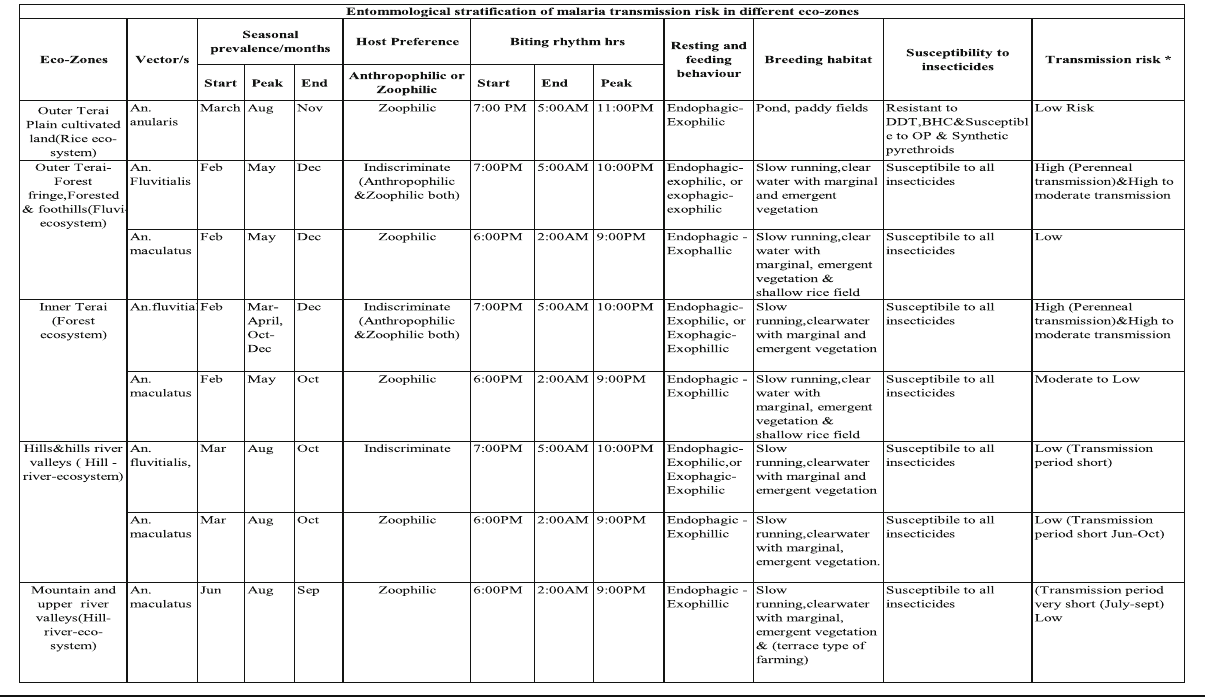
Table 1 Entomological stratification of malaria transmission risk in different ecological settings of Nepal